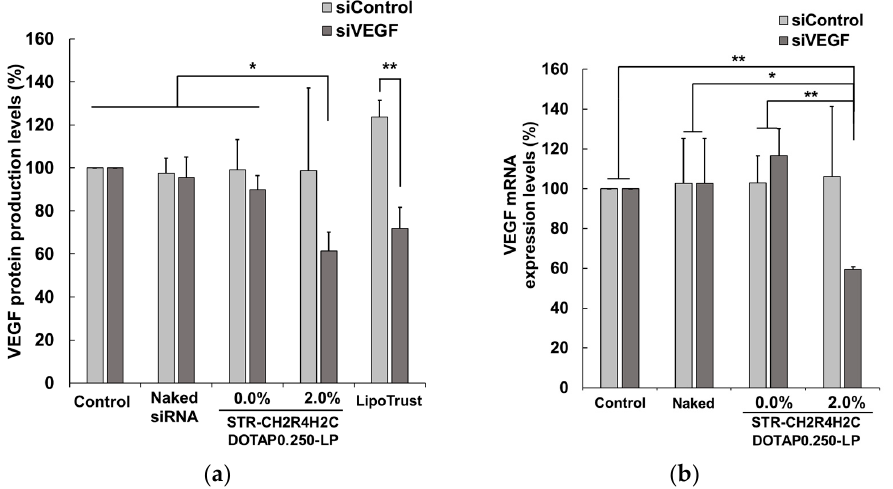
Figure 4. Suppressive effects of STR-CH2R4H2C-LP-siVEGF lipoplexes on VEGF production ( a )